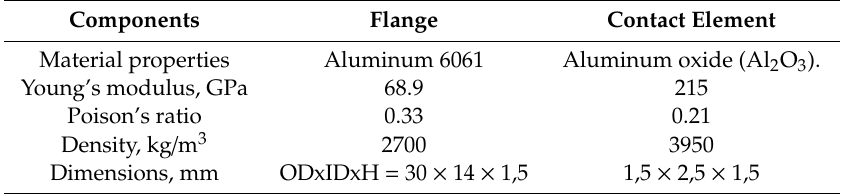
Table 2. Properties of the materials and dimensions of components used for